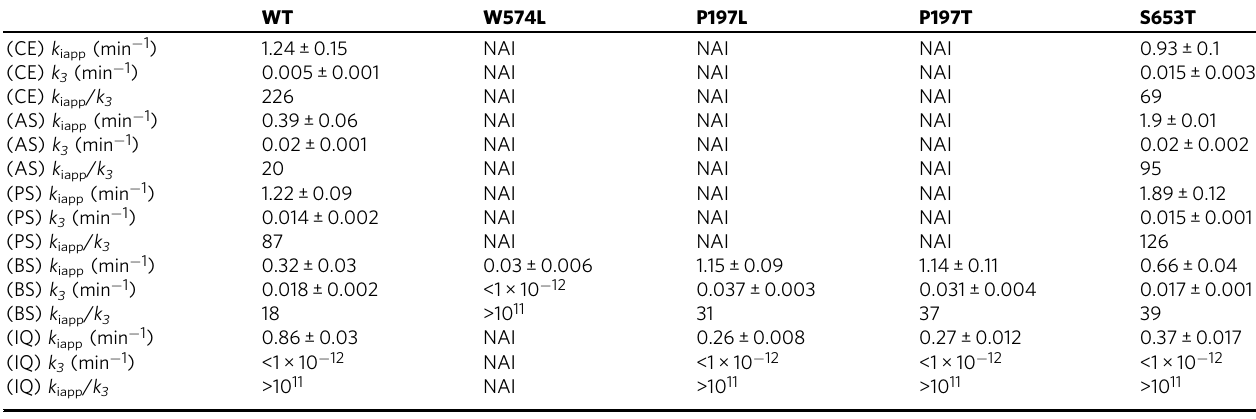
Table 2 Rate constants involved in accumulative inhibition ( k iapp and k 3 ) for WT At AHAS and its